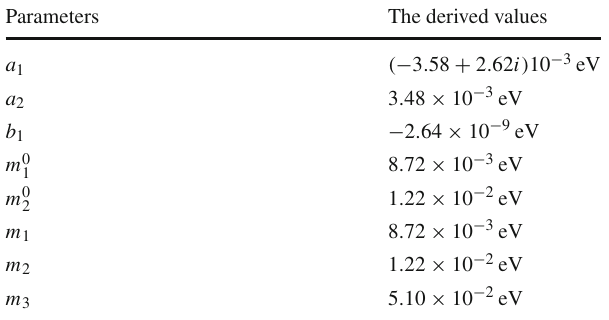
Table 2 The model parameters in the case m 0